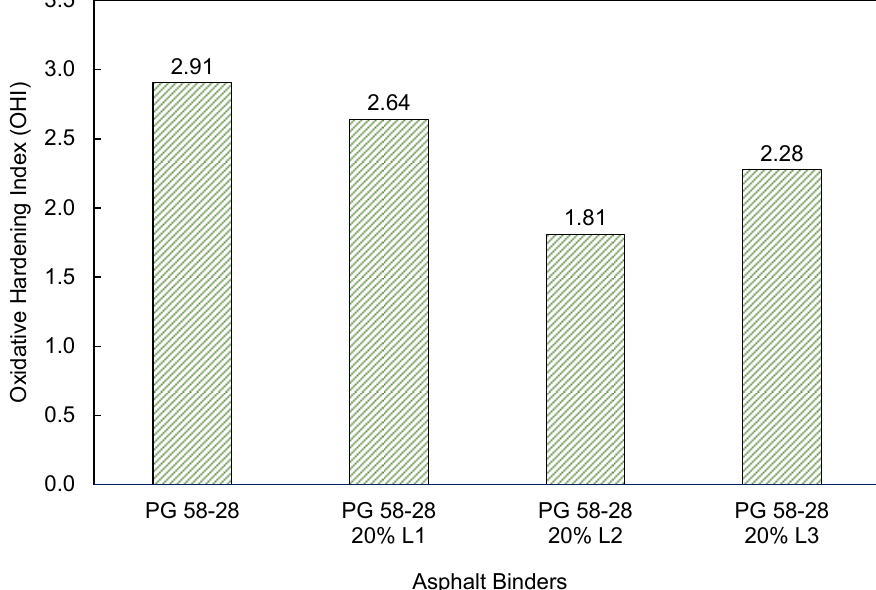
Figure 6. Oxidative Hardening Indices of Binder Blends.